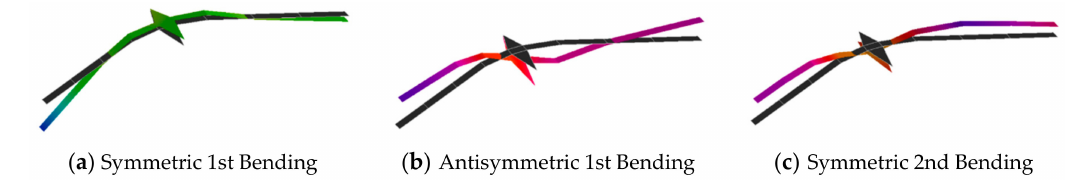
Figure 12. The first three elastic modal shapes obtained from GVT.